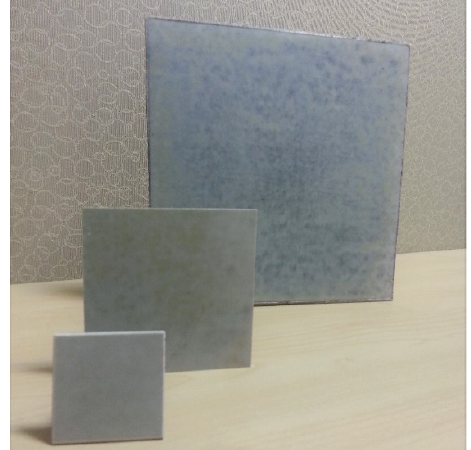
Figure 1. OGC, oil-extracted GCW-reinforced HDPE composite laminate. Table 3. Summary of type of composites investigated in this study.